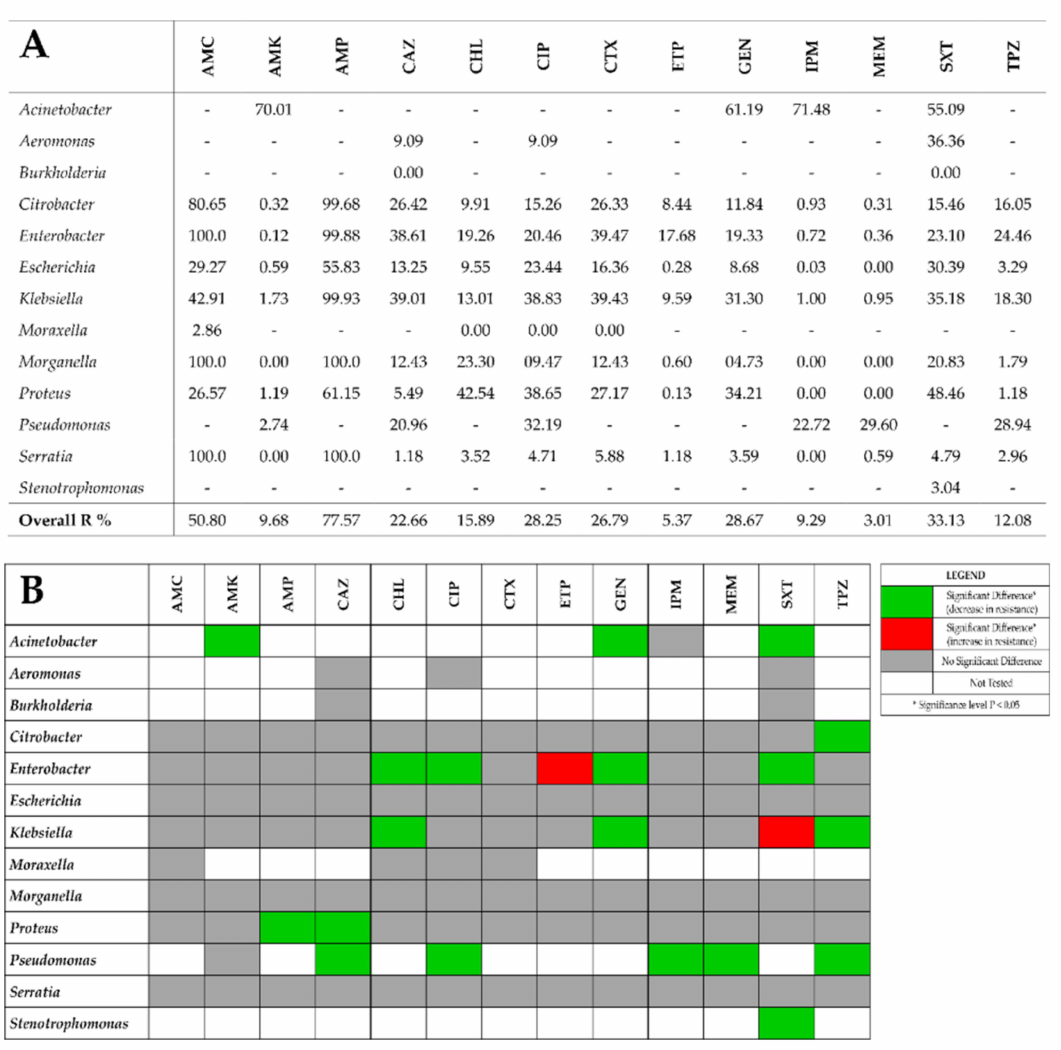
Figure 1. ( A ) Average resistance rates against tested antimicrobial agents and GNBs studied. Overall R% indicates the weighted average of resistance rates taking into count the number of isolates and the relevant resistance rates. ( B ) Trends in bacterial resistance to tested antibiotics across the study period (2017 vs 2020) using χ 2 test.